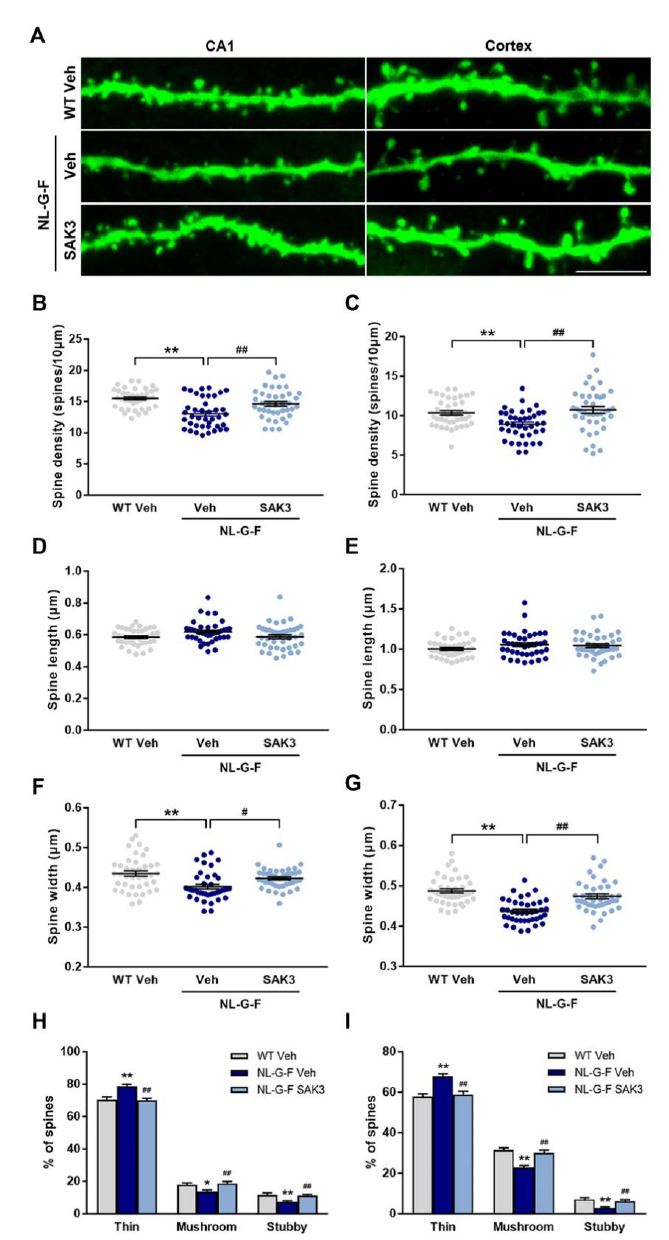
Figure 4. SAK3 administration ameliorates the dendritic spine abnormalities in NL-G-F mice. ( A ) Representative images of dendrites in the hippocampal CA1 and cortex (Scale bar, 5 µ m). ( B ) Spine density per 10 µ m dendritic length in the hippocampal CA1 and ( C ) cortex ( n = 40 dendrites from 4 mice per group); CA1: F (2, 117) = 13.67, p < 0.01; Cortex: F (2, 117) = 8.302, p < 0.01. Spine length in ( D ) the hippocampal CA1 and ( E ) the cortex. Spine width in ( F ) the hippocampal CA1 and ( G ) the cortex; CA1: F (2, 117) = 8.526, p < 0.01; Cortex: F (2, 117) = 24.3, p < 0.01. ( H , I ) The percentage of the type of spines in the hippocampal CA1 and cortex, respectively; CA1 thin: F (2, 117) = 10.91, p < 0.01; CA1 mushroom: F (2, 117) = 5.77, p < 0.01; CA1 stubby: F (2, 117) = 6.843, p < 0.01; Cortex thin: F (2, 117) = 16.93, p < 0.01; Cortex mushroom: F (2, 117) = 18.14, p < 0.01: Cortex stubby: F (2, 117) = 11.73, p < 0.01. More than 2000 spines in the hippocampal CA1 and more than 1500 spines in the cortex were assessed on 40 dendrites from 9–10 neurons from 4 mice per group. Error bars represent SEM. * p < 0.05, ** p < 0.01 vs. vehicle-treated WT mice; # p < 0.05, ## p < 0.01 vs. vehicle-treated NL-G-F